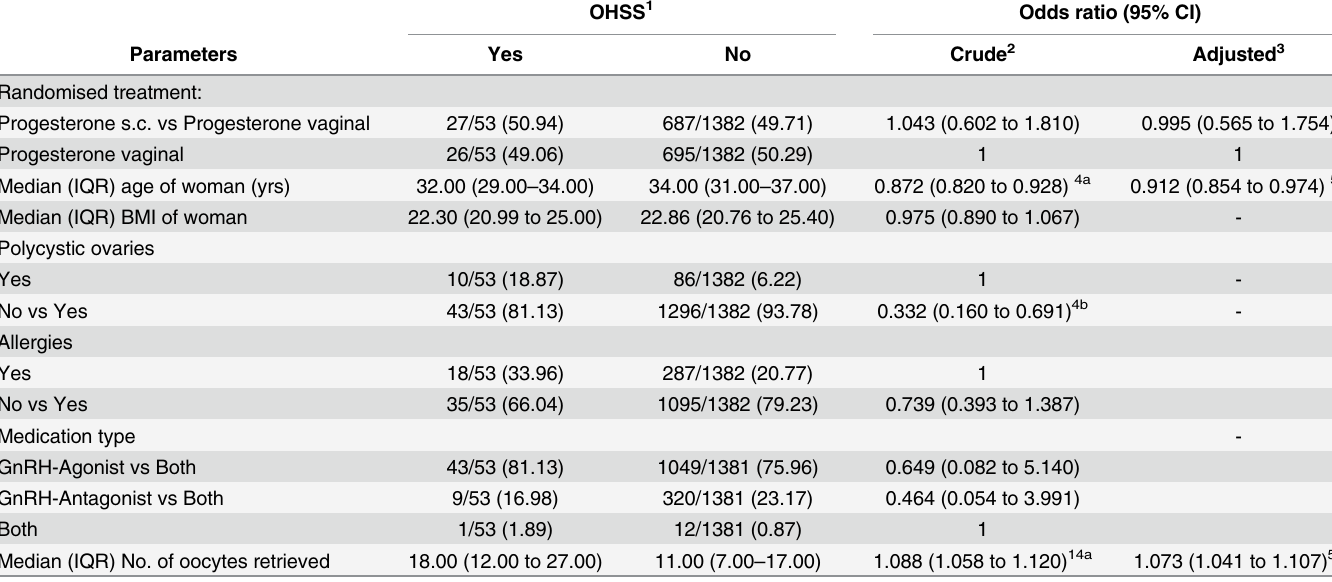
Table 5. Predictors of onset of OHSS after progesterone treatment. Figures are numbers (percentages) unless stated otherwise. OHSS